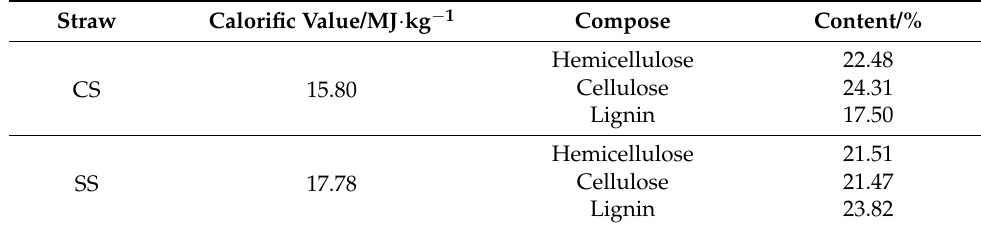
Table 2. Calorific value and wood fiber content of CS and SS.